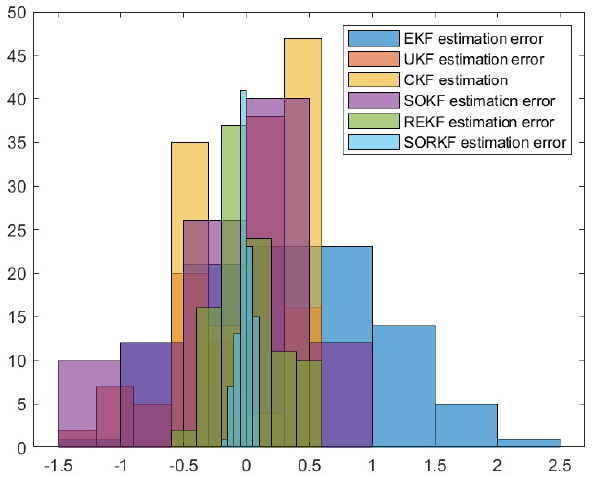
Figure 15. Histogram of R2 positioning estimation error in random topology formation.